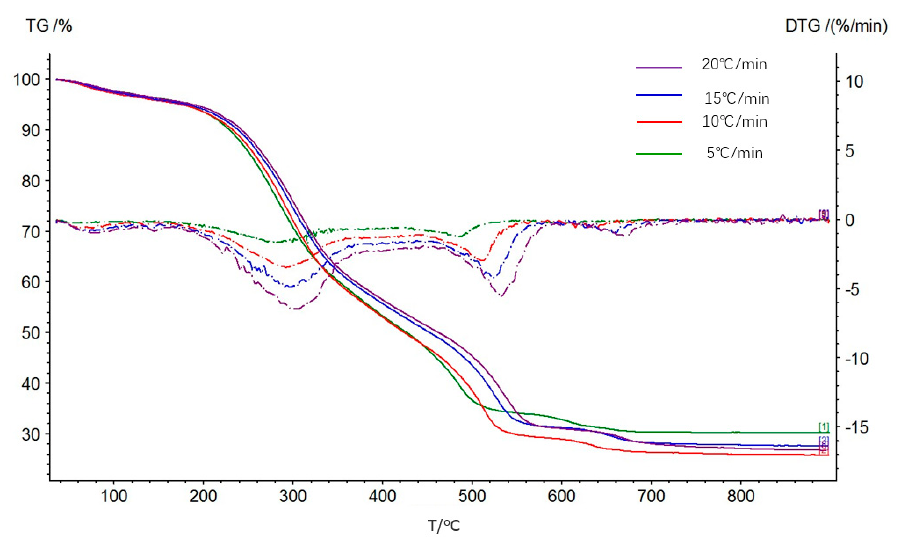
Figure 4. The TG and DTG curves of the chicken manure thermal decomposition for different heating rates in the presence of air atmosphere.